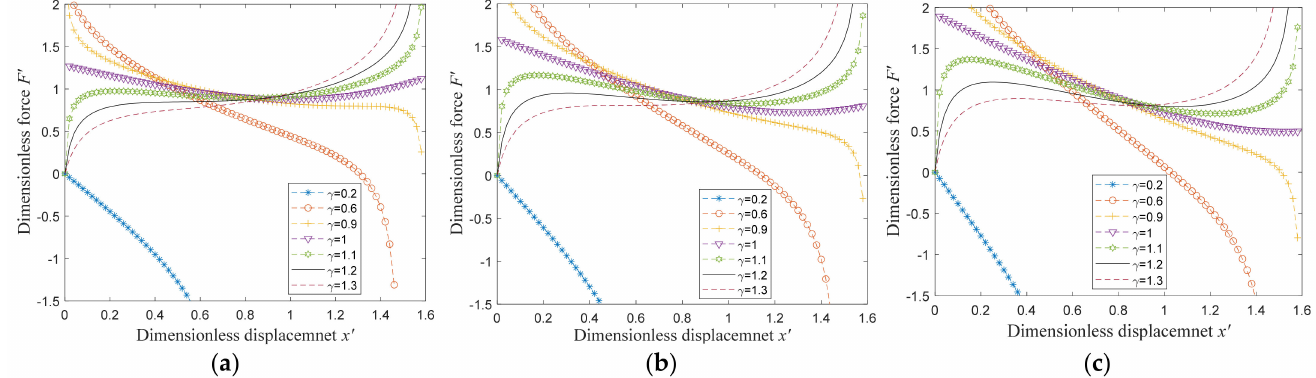
Figure 5. Dimensionless force–deflection curves with the various values of γ 2 : ( a ) α = 0.8, γ 1 = 0.8; ( b ) α = 1.0, γ 1 = 0.8; ( c ) α = 1.2, γ 1 =